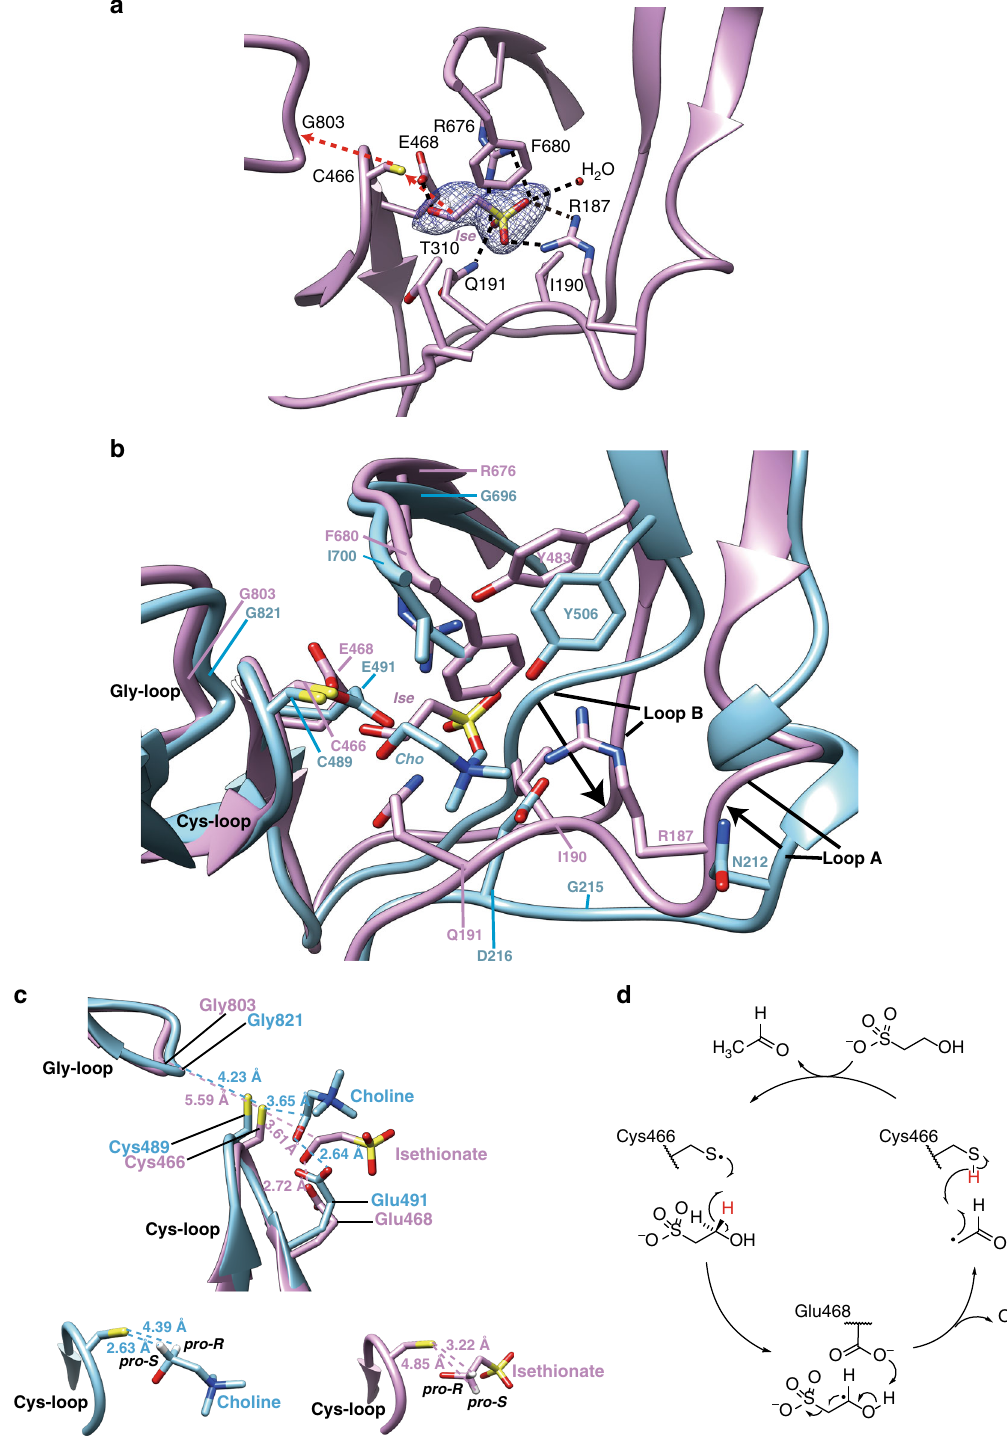
Fig. 3 IseG active site structure. a IseG active site in complex with the substrate isethionate. The proposed pathway for hydrogen atom transfer is indicated by red arrows, and all hydrogen bonds are indicated by black dashed lines. 2Fo-Fc electron densities for isethionate are shown at 1.0 σ . b Superposition of the IseG active site (plum) with CutC active site (cyan, PDB code 5FAU). Key residues involved in substrate binding and radical chemistry are displayed and labeled. The conformational changes in two substrate-coordinating loops are indicated by black arrows. c Structural model of the Gly-loop, Cys-loop, and the substrates. The distances between the key atoms are indicated. Comparison of the orientation of the modeled C1 hydrogens of isethionate (plum) and choline (cyan), suggesting that different enantiotopic hydrogens are abstracted by the thiyl radical. The distances between thiyl radical site and C1 hydrogens are labeled. d Proposed mechanism of isethionate cleavage by GUF (IseG). The thiyl radical, which is transiently generated by the G (cid:129) cofactor in all GREs, abstracts a hydrogen (shown in red) from the substrate isethionate, and returns it to form the product